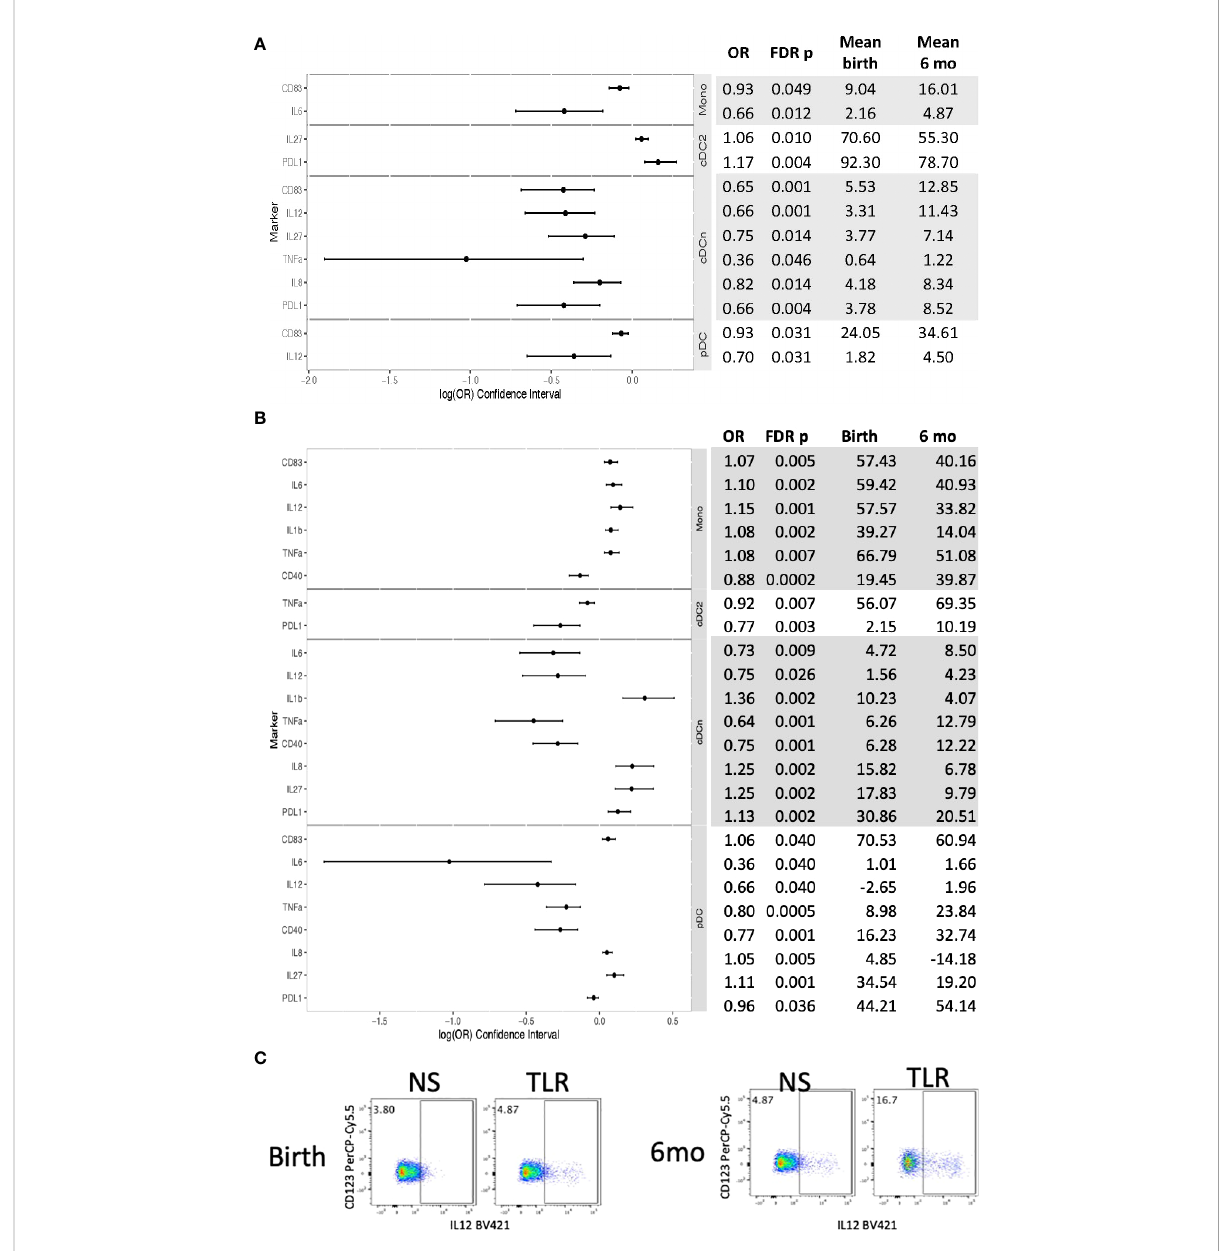
FIGURE 4 Differential phenotypic and functional characteristics of APC in HUU between birth and 6 months of life. Data were derived from 64 HUU at birth and 45 HUU at 6 months. (A) Forest plot and summary statistics of signi fi cant phenotypic differences. (B) Forest plot and summary statistics of signi fi cant functional differences. (C) Representative scatter plots of IL12+ cDCn (Lin-HLADR+CD14-CD123-CD1c-) illustrating differences between birth and 6 months of